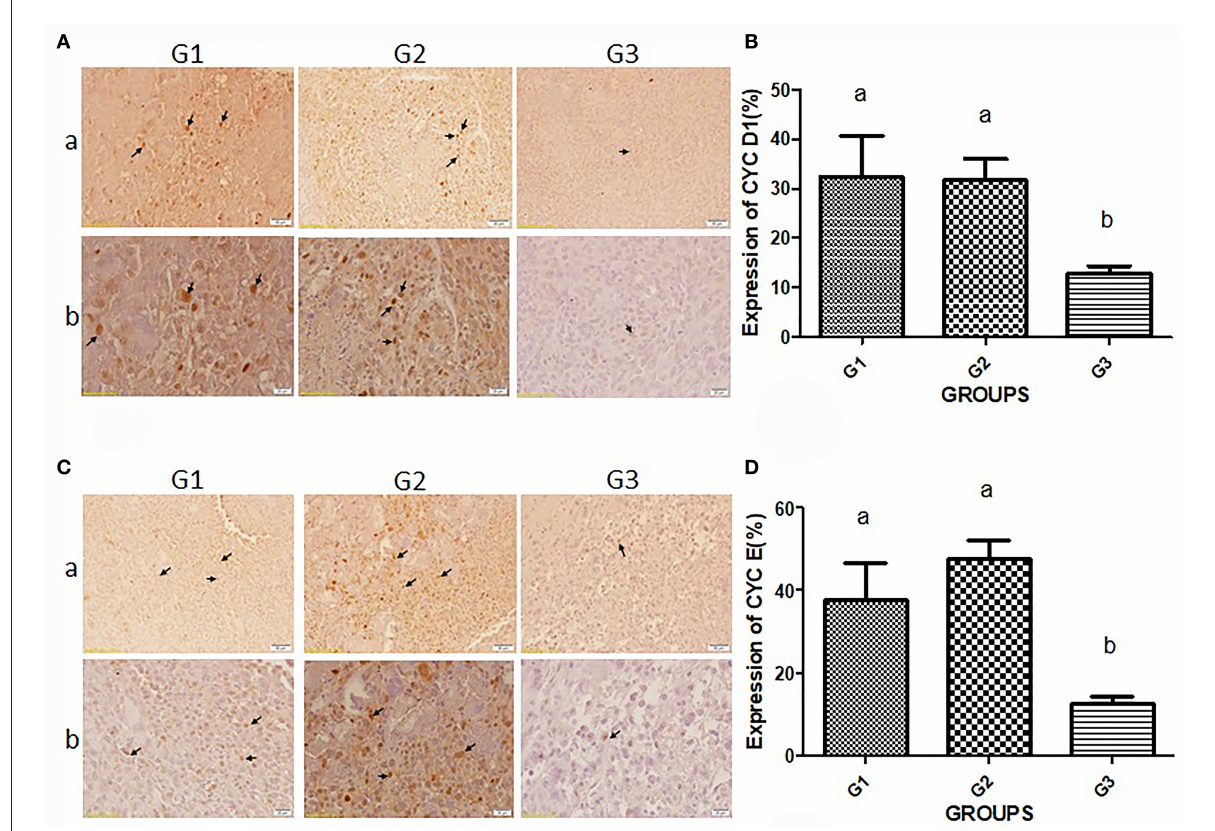
FIGURE3 Immunodetection of G1 cyclins proteins. Protein expression of cyclin D1 (A) and cyclin E (C) in three different experimental groups are demonstrated. Panel b ( × 400) shows higher magnification of photomicrographs in panel a ( × 40). Arrows in panels a and b of (A) and (C) demonstrate the protein expression of cyclins D1 and E, respectively. Brown nuclei are known as mitotic cells that decreased in response to the bipSUR compared to G1 & G2. The percentage of protein expression of cyclin D1 (B) and cyclin E (D) is revealed in all experimental groups. A remarkable reduction of G1 cyclins was observed in response to the bipSUR. Different letters (a and b) demonstrate significant differences among groups at P <